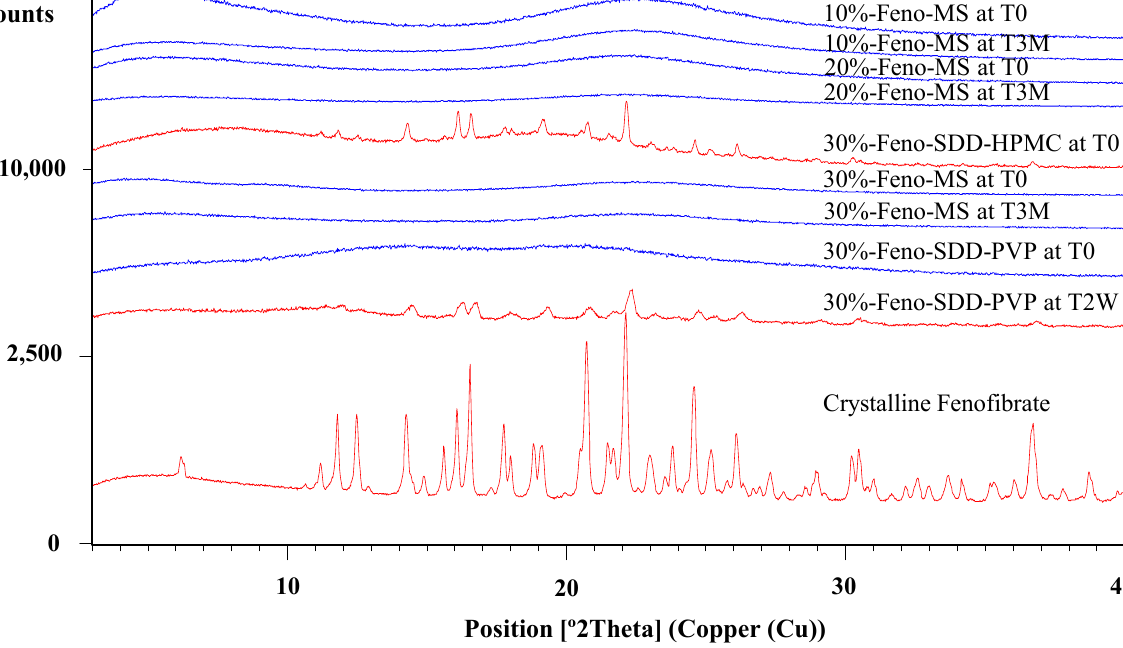
Figure 1. The PXRD overlay of Feno-MS samples (10%, 20%, and 30% drug load at T0 and T3M under accelerated conditions of 40 °C/75% RH in open dish), Feno-loaded SDD samples using polymers PVP and HPMC (30% drug load at T0 and T2W under the same accelerated conditions), and crystalline fenofibrate.